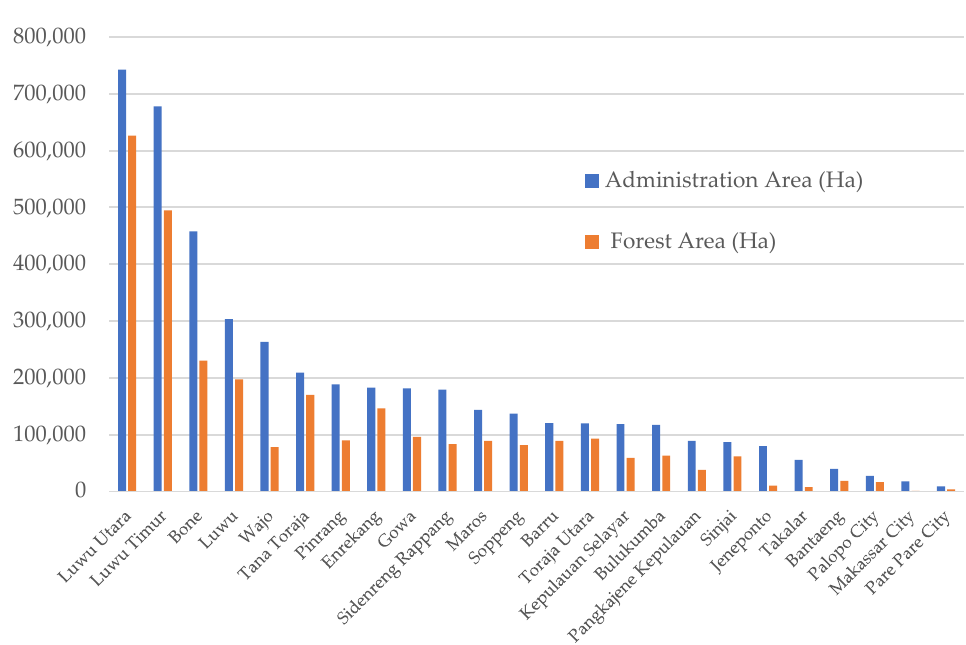
Figure 5. Distribution of forest area in each regency/city area.